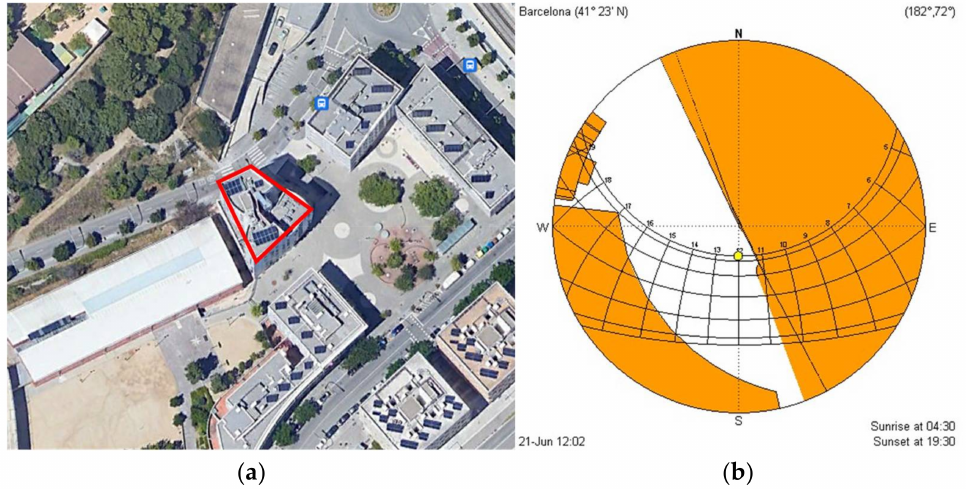
Figure 2. Torre Bar ó district, ( a ) Dw2’s position and ( b ) the stereographic view from Dw2’s